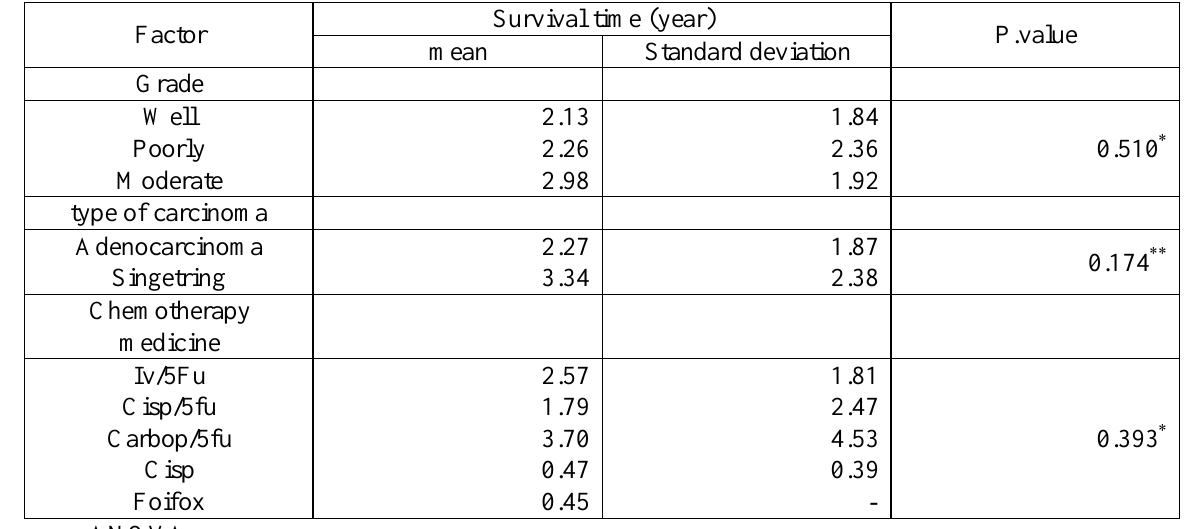
Table 4: Relationship between the mean survival of patients and grade, type of carcinoma, and type of CT